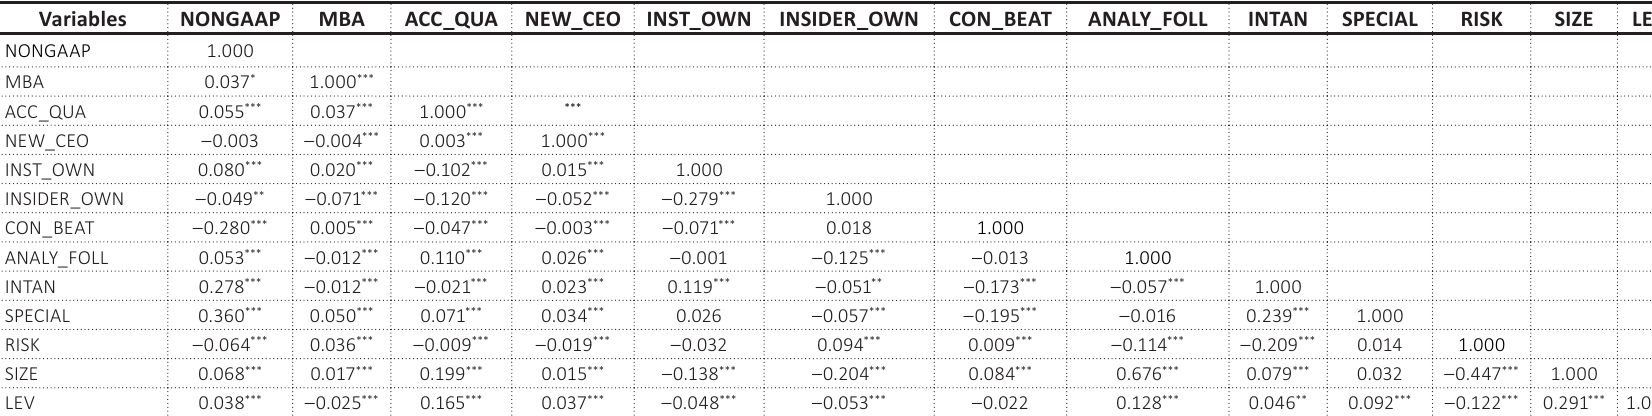
Table 4. Correlation analysis